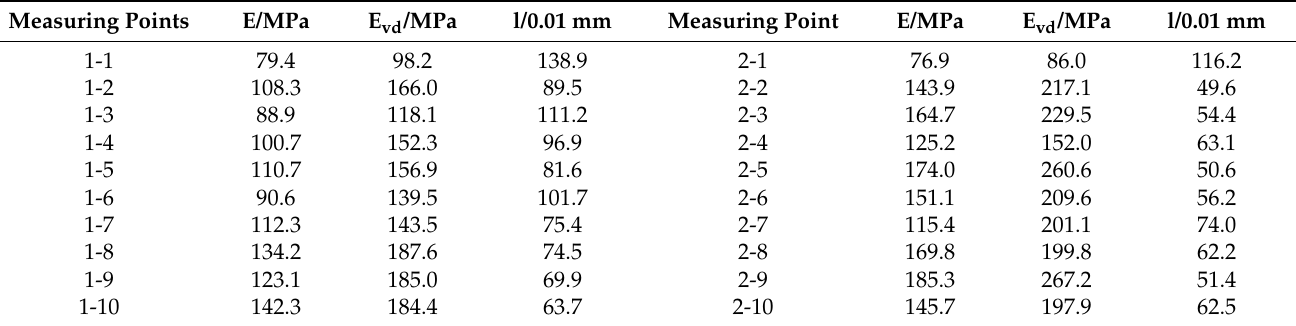
Table 5. Performance test results of fixed point test